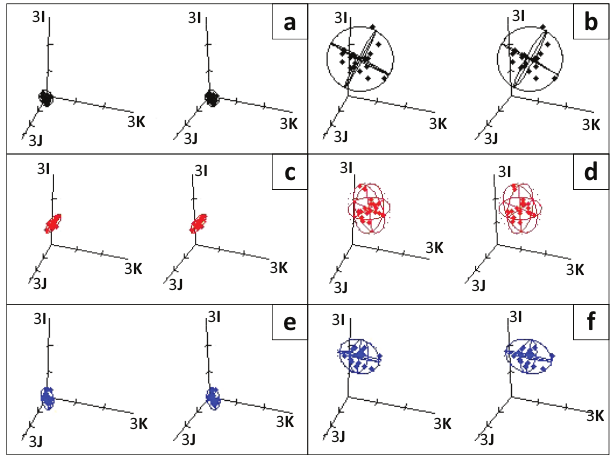
Note: The origin of the stereo-pairs representing the anterior corneal surface (a, c, e) is placed at 44 I D and that of the posterior corneal surface (b, d, f) is placed at 53 I D. FIGURE 5: (a ‒ f) Rotated stereo-pair scatter plots for the anterior (a, c, e) and posterior (b, d, f) surface of the cornea. All six stereo-pair scatter plots have an axis length of 3 D and the tick interval is 1